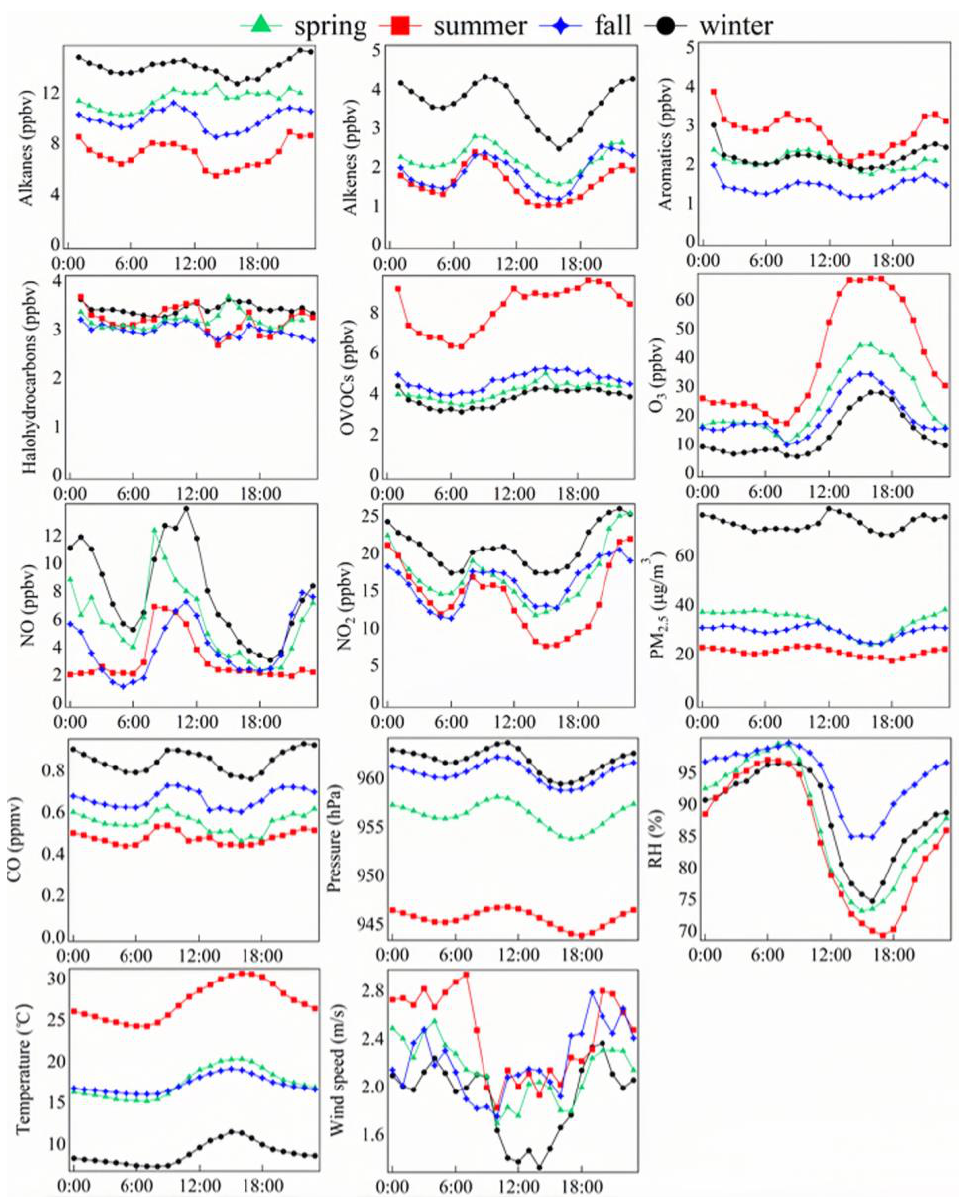
Figure 5. Seasonal diurnal variations of VOCs, O 3 , CO, and meteorological parameters (pressure, relative humidity, temperature, and wind speed) in Yibin during the campaign.